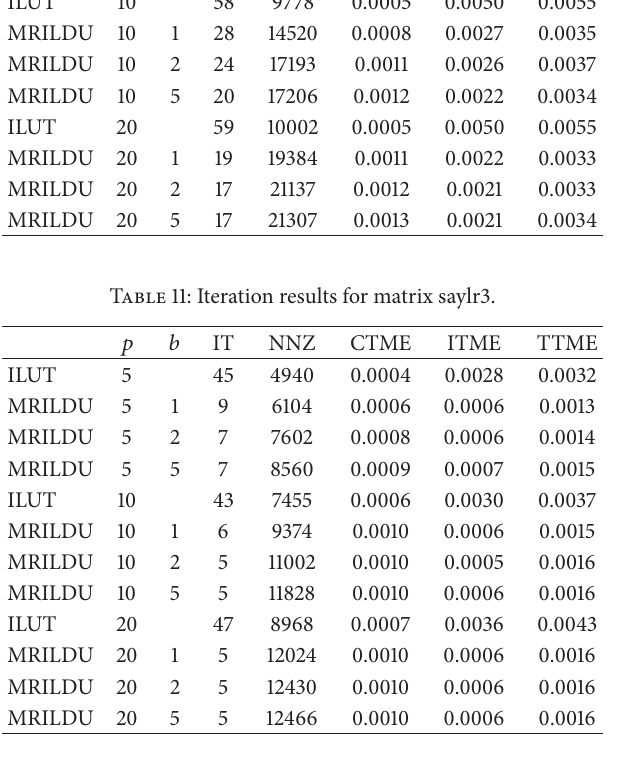
Table 12: Iteration results for matrix sherman3.